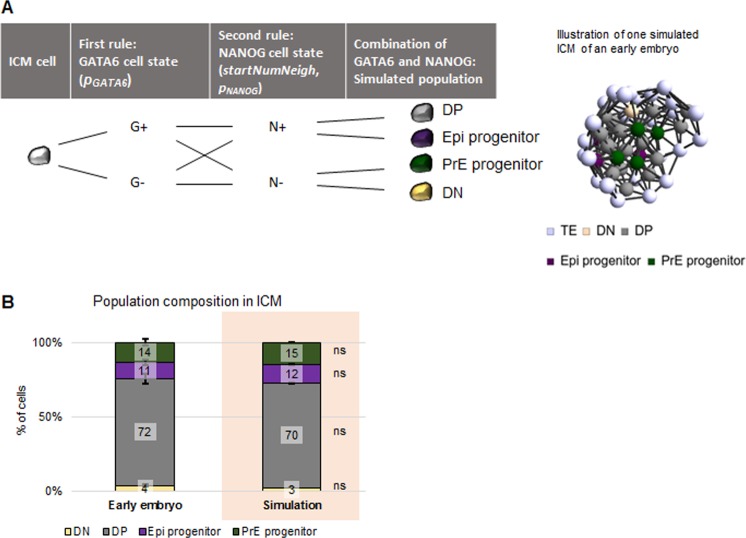
Simulation of two rules recapitulates population composition in early blastocysts.(A) Diagram depicting the population type assignment to the cells in the simulations (left) and an example of a simulated three-dimensional cell distribution (right). See main text and S1 Text for further details on the two rules and parameters. (B) Proportion of DN, DP, Epi progenitor and PrE progenitor ICM cells in early blastocysts in data II (first bar) and upon simulating the model (pink background) presented in (A). For the parameters used, see the main text and S1 Text. z-test; *: p<0.05. The error bars indicate the standard errors of the means.